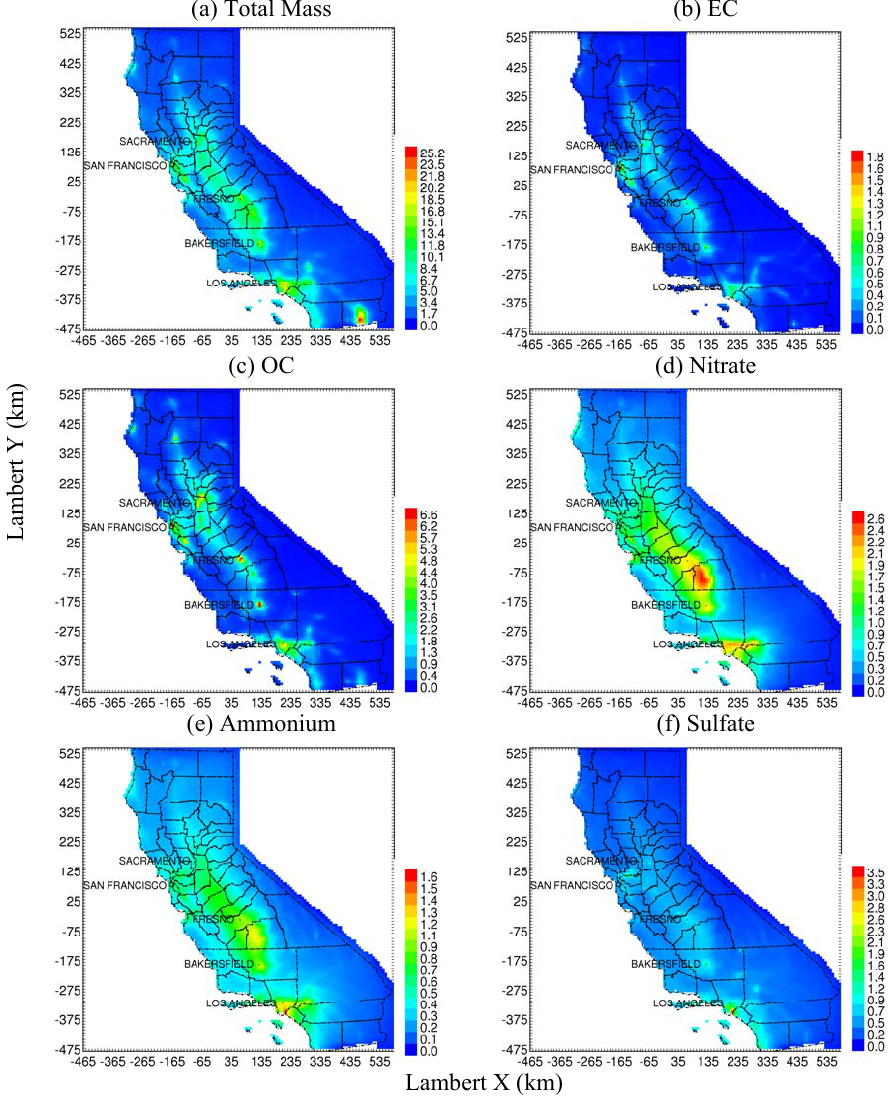
Fig. 3: Annual average Particulate Matter 2.5 (PM 2.5 ) concentrations in CA for the present-day (2000-06) (a) total mass, (b) elemental carbon, (c) organic carbon, (d) nitrate, Fig. 3. Annual average PM 2 . 5 concentrations in CA for the present-day (2000–2006) (a) total mass, (b) elemental carbon, (c) organic carbon, (e) ammonium, and (f) sulfate. (d) nitrate, (e) ammonium, and (f)